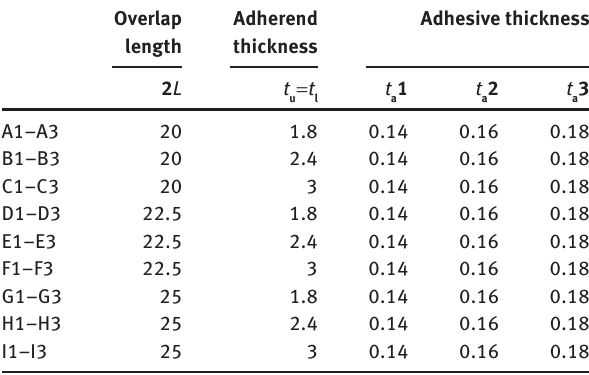
Table 1 Single-lap joint dimensions (mm).